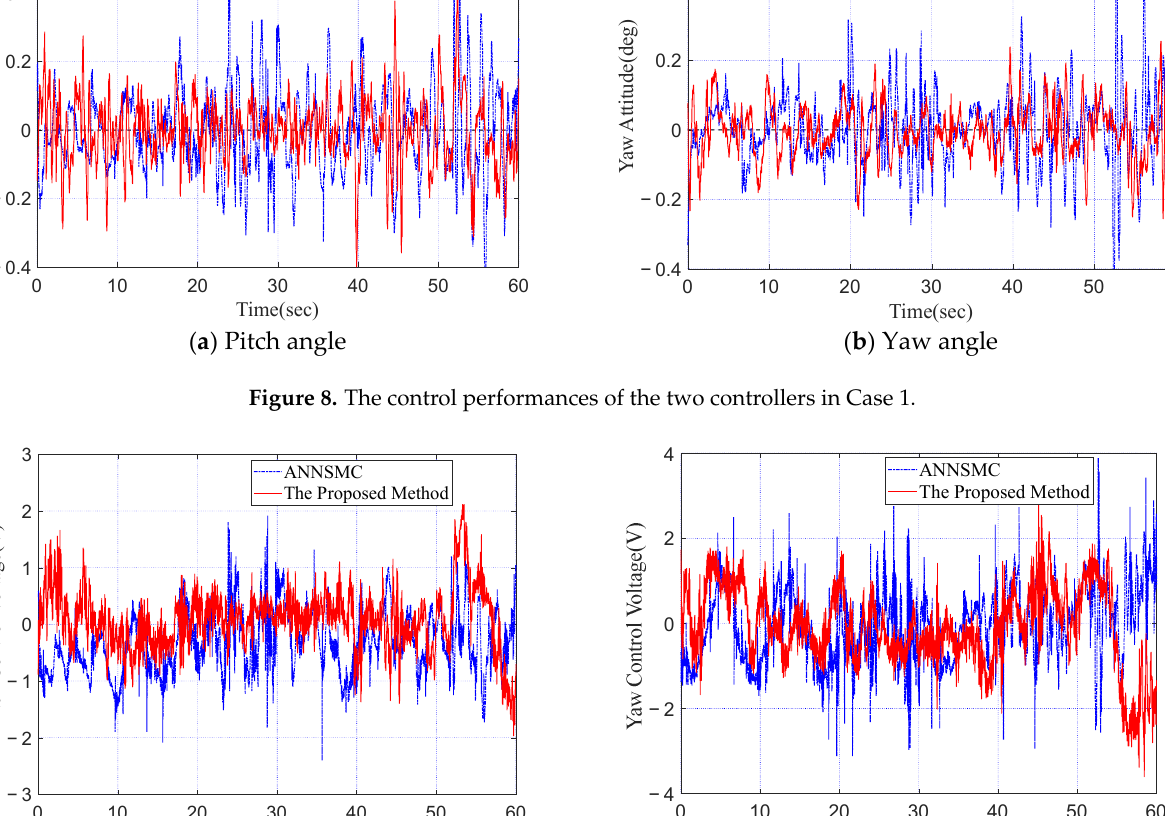
( b ) The disturbance estimation for yaw gimbal Figure 10. The disturbance estimations of the two controllers in Case 1.